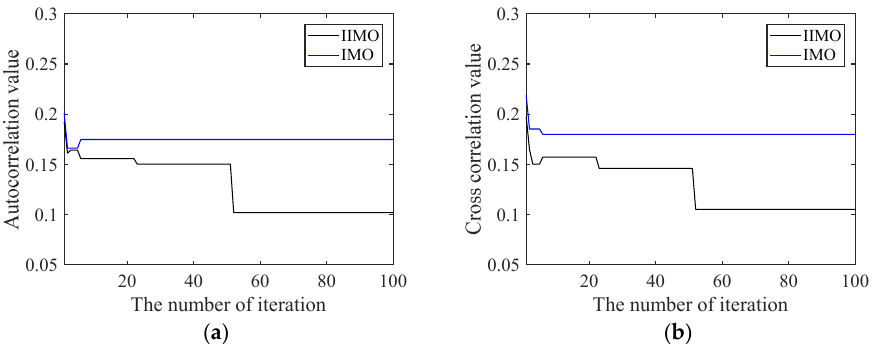
Figure 2. Comparison results between IIMO and IMO under L = 3 and N = 128 on ( a ) Average autocorrelation, ( b ) Average cross-correlation.